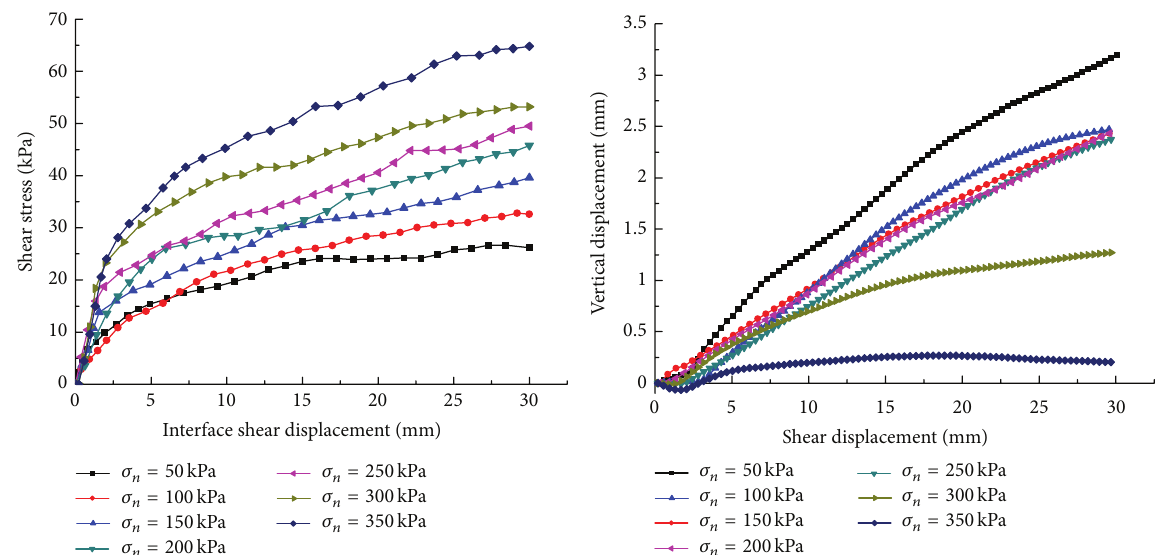
Figure 3: Test results for the interface between clay and #0 plate (initial normal stress of 400kPa).